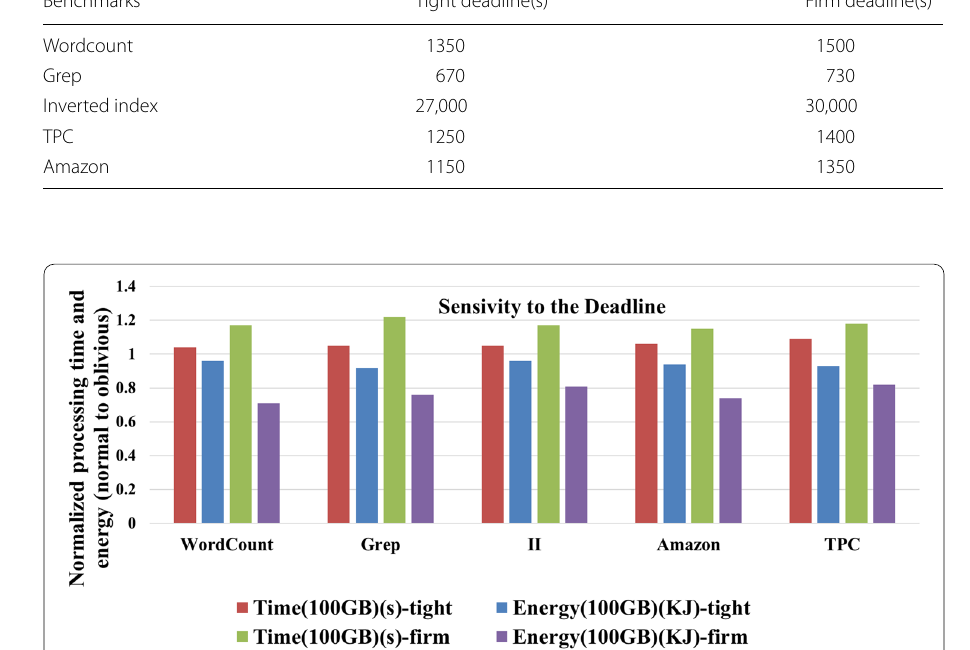
Fig. 13 Sensitivity analysis to